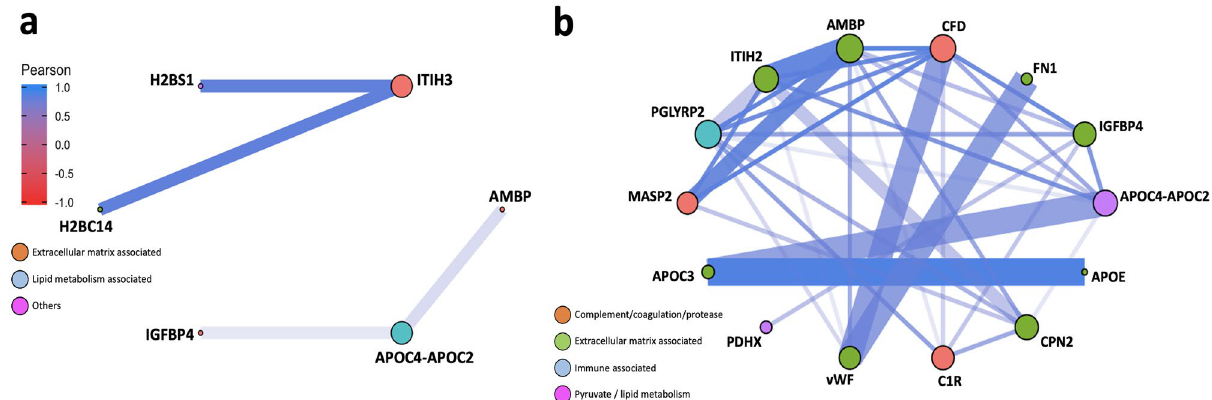
Figure 4. Network analysis. Network plots illustrating protein–protein interactions in ( a ) EOPE versus healthy pregnancy and ( b ) LOPE versus healthy pregnancy. Each node represents one protein; and each edge represents a pairwise Pearson correlation between proteins. The networks only show Pearson correlation coefficient > 0.7 or < − 0.7. Node: colour coded according to the functional classification of proteins annotated by DAVID database; size proportional to the corresponding eigenvector centrality (network influence). Edge: colour and length proportional to the Pearson correlation coefficient; width proportional to the scores derived from STRING database. Source data are provided as a Source Data